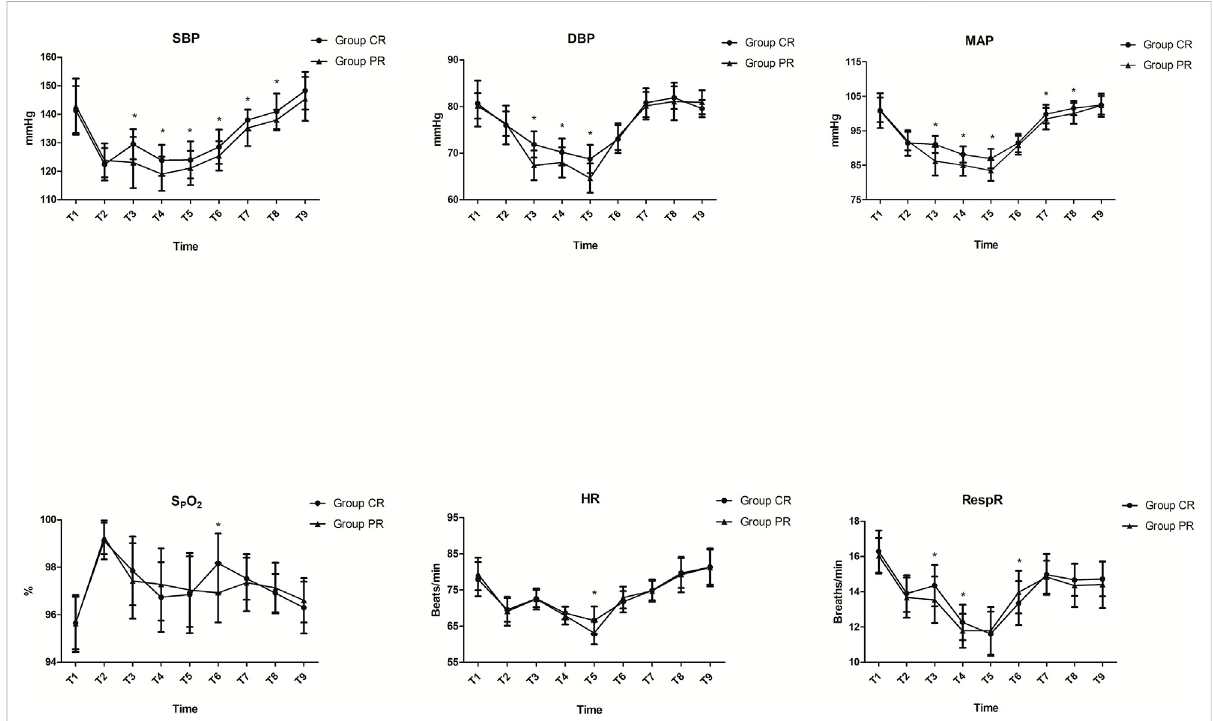
Hemodynamic measurements. Systolic blood pressure (SBP) was signi fi cantly higher from T3 to T8, whereas diastolic blood pressure (DBP) values declined signi fi cantly less from T3 to T5 in the ciprofol-remifentanil (CR) group ( p < 0.05). Mean arterial blood pressure (MAP) was also signi fi cantly higher in the CR group from T3 to T8, except during T6 ( p < 0.05). SpO 2 and heart rate (HR) were signi fi cantly decreased at T6 and T5, respectively, in the propofol-remifentanil (PR) group, and the respiratory rate (RespR) was signi fi cantly increased at T3, T4, and T6 in the CR group ( p < 0.05). Time metrics are as follows: T1: arrival at the examination room; T2: immediately before start of ciprofol or propofol; T3: immediately after entering the glottis; T4: 3 min after start of entering the glottis; T5: 6 min after start of entering the glottis; T6: end of fi beroptic bronchoscopy (FB); T7: 3 min after FB; T8: 6 min after FB; T9: before leaving the postanesthesia care unit